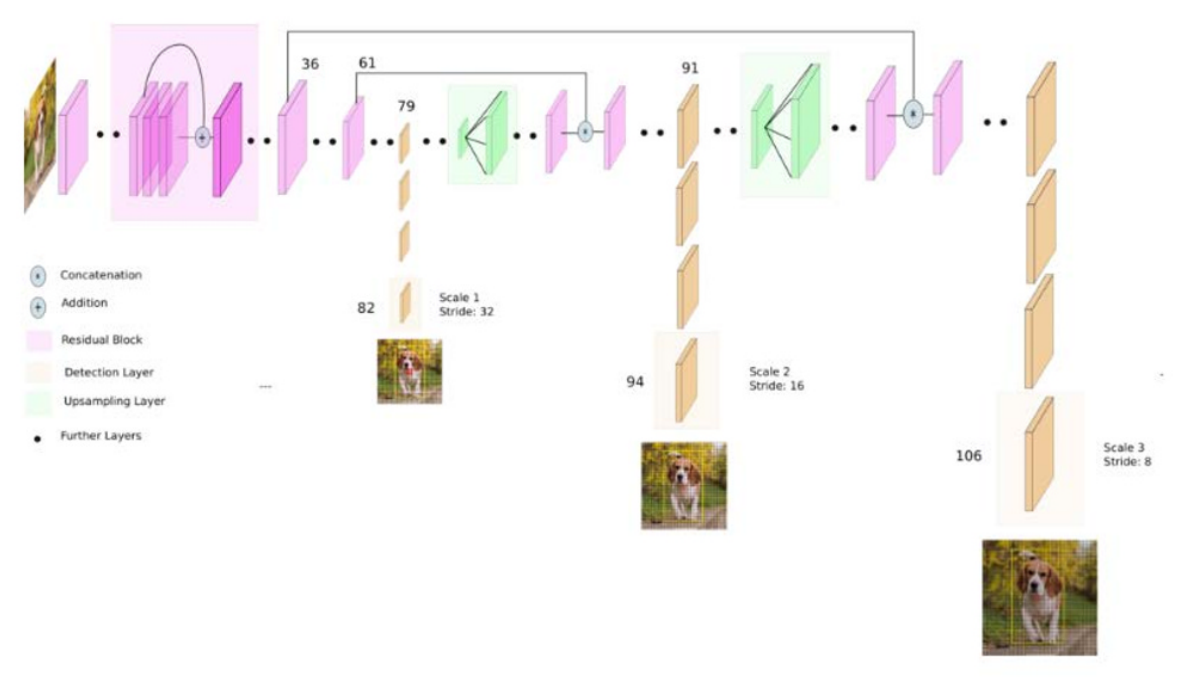
Fig. 5. YOLO V3 network